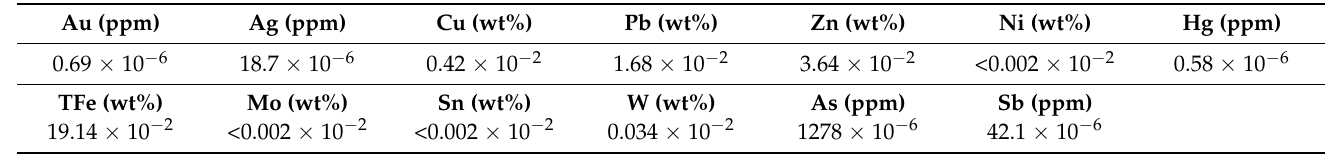
Table 1. Rock sample geochemistry (No.